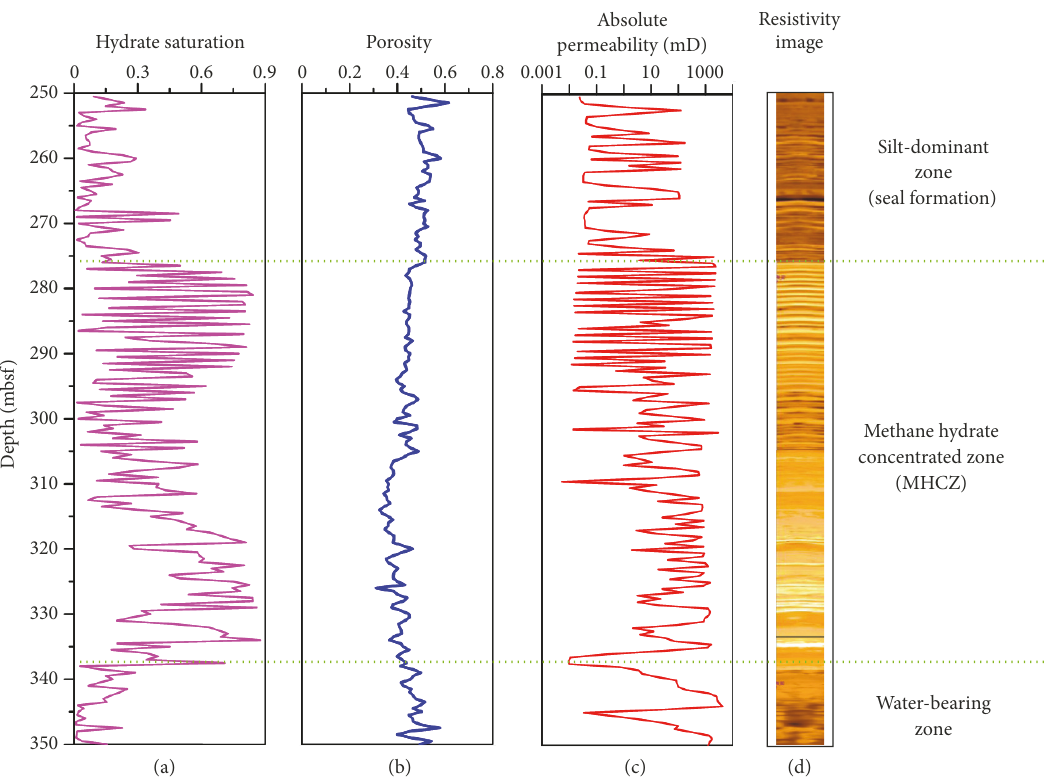
Figure 3: Depth profiles of hydrate saturation, porosity, and absolute permeability based on the well logging and core data with resistivity image [4, 22, 24]. Green dotted lines show the position of the top and bottom of the